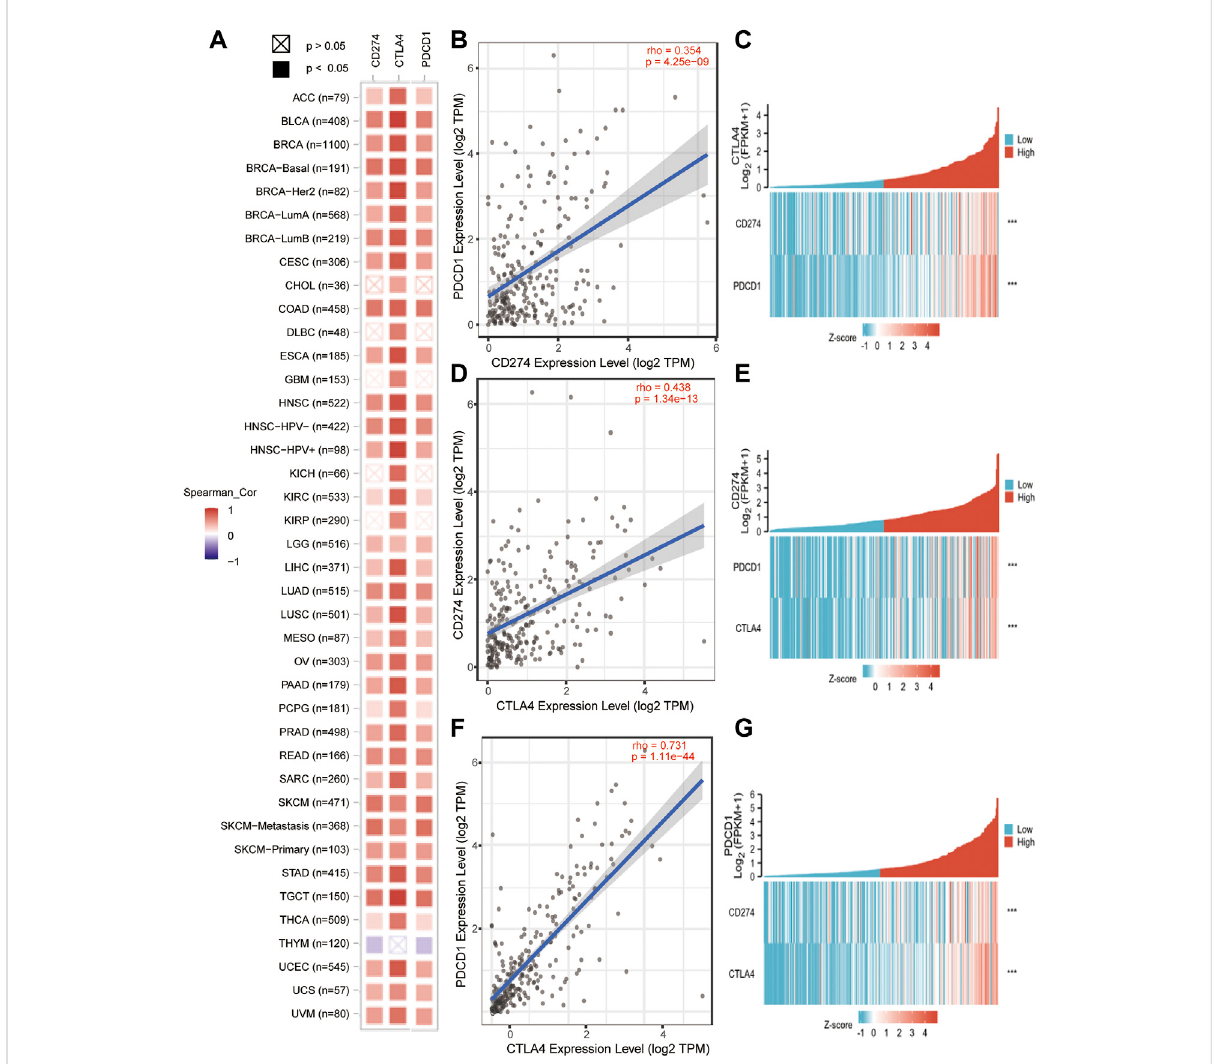
FIGURE 7 PD-1/PD-L1/CTLA-4 co-expressed in pan-cancer and SARC. (A) PD-1/PD-L1/CTLA-4 positively co-expressed in pan-cancer from TCGA database using TIMER2.0 tool (Spearman_ Cor > 0, p < 0.05). (B,D,F) PD-1, PD-L1 and CTLA-4 positively correlated with each other in SRAC from TCGA database using TIMER2.0 tool (rho > 0, p < 0.05). (C,E,G) The heatmap showed that PD-1, PD-L1, CTLA-4 were clearly co-expressed in